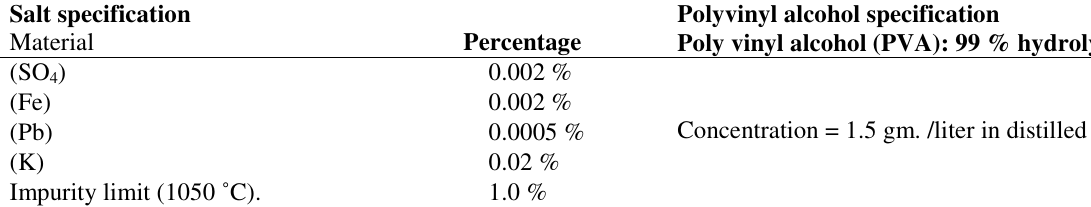
Characteristics of the used quenching medias. Salt specification